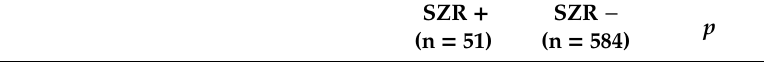
Table 1. Baseline